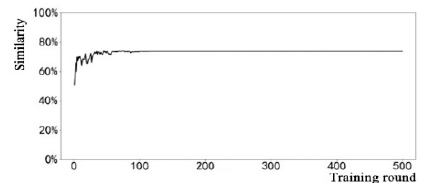
Figure 28. Expert-driven learning with a factor of ½.